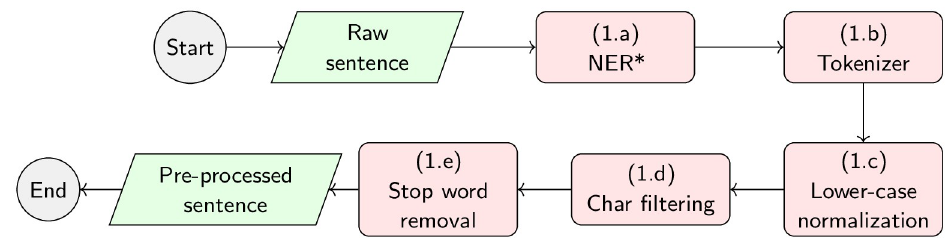
Fig 4. Detailed sentence pre-processing workflow that are implemented in our experiments. The pre-processing stage takes an input sentence and produces a pre-processed sentence as output. ( � ) The named entity recognizer are only evaluated in ontology-based